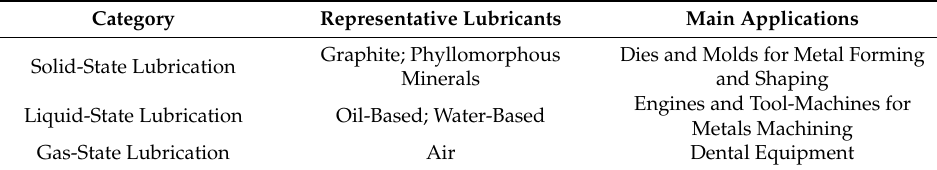
Table 1. Main categories of lubrication and representative examples.